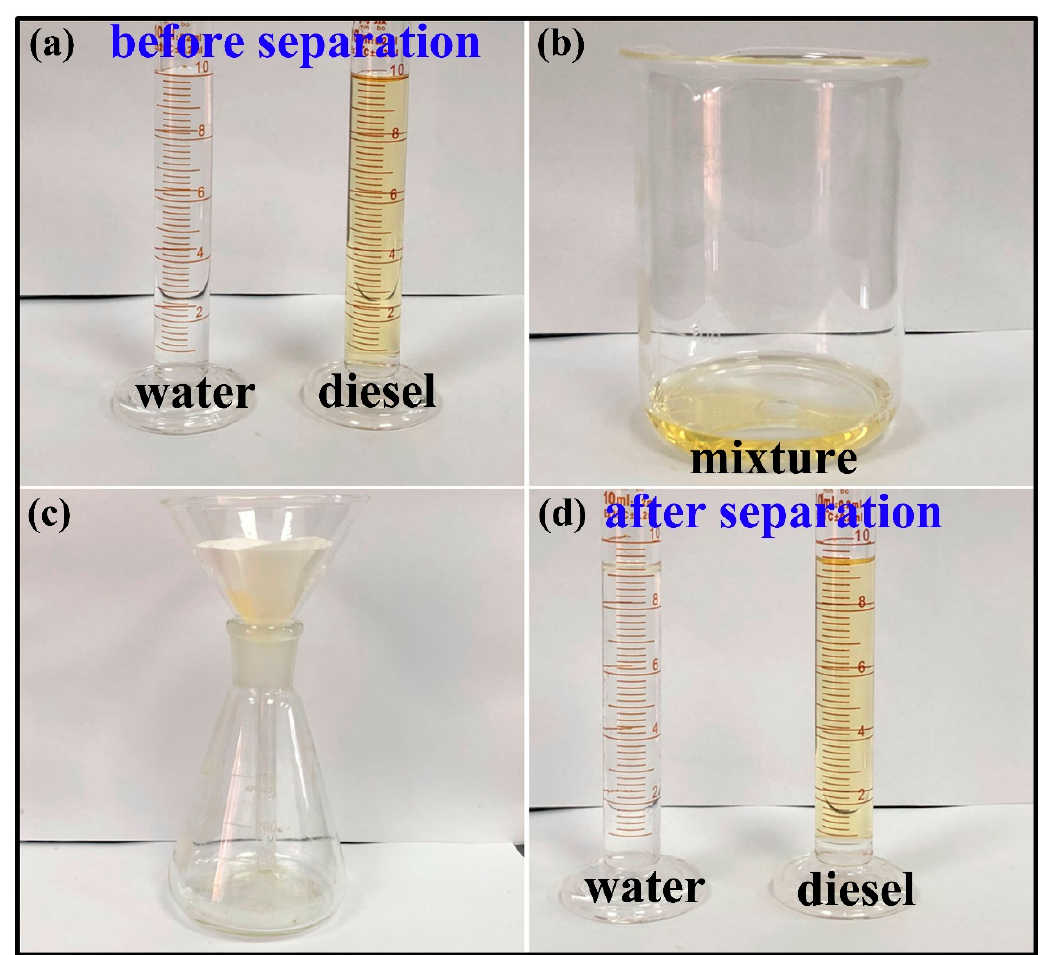
Figure 11. Images of ( a ) volume of water and diesel before separation; ( b ) as-prepared mixtures of 10.0 mL water with 10.0 mL diesel; ( c ) the equipment of separation of oil and water; ( d ) volume of water and diesel after separation.